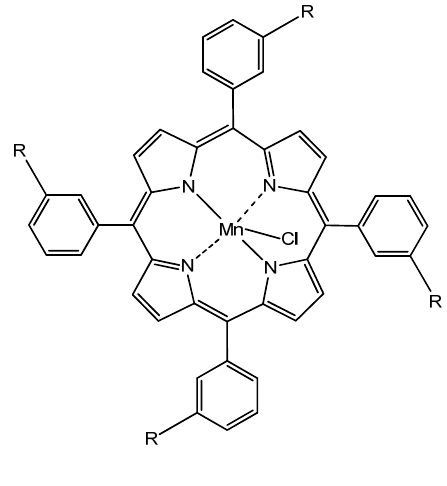
Figure 2. The chemical structure of the ionophores. Ionophore (1): manganese(III)